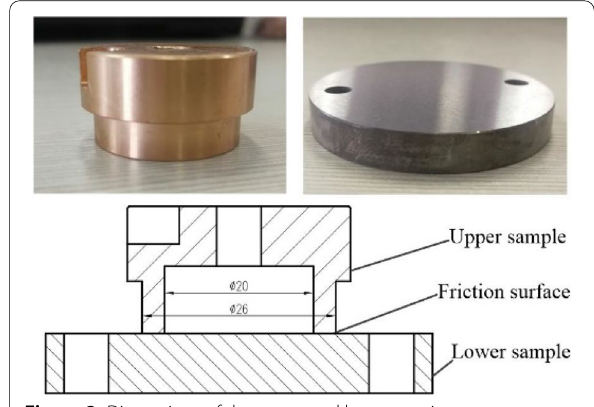
Figure 2 Dimensions of the upper and lower specimens